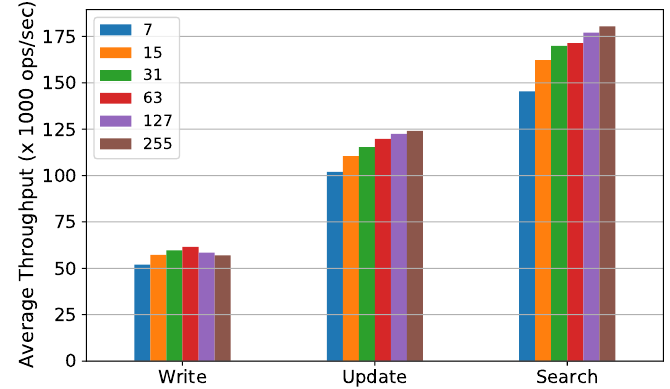
Figure 6. The throughput of the InK key-value